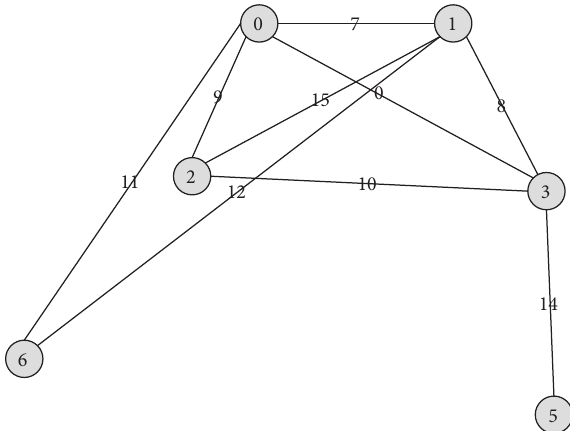
Figure 4: Filter network after high- and low-importance Table 3: Number of triangle-subgraph sets of the complex network after filtering.